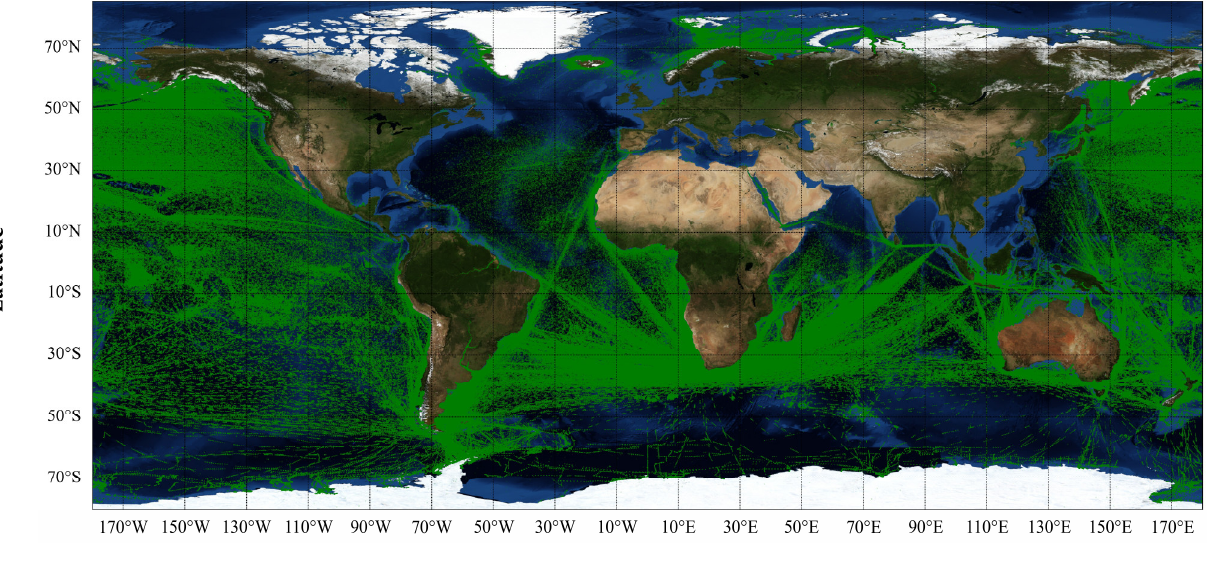
Figure 1. The partial AIS data received by the HY-1C satellite.